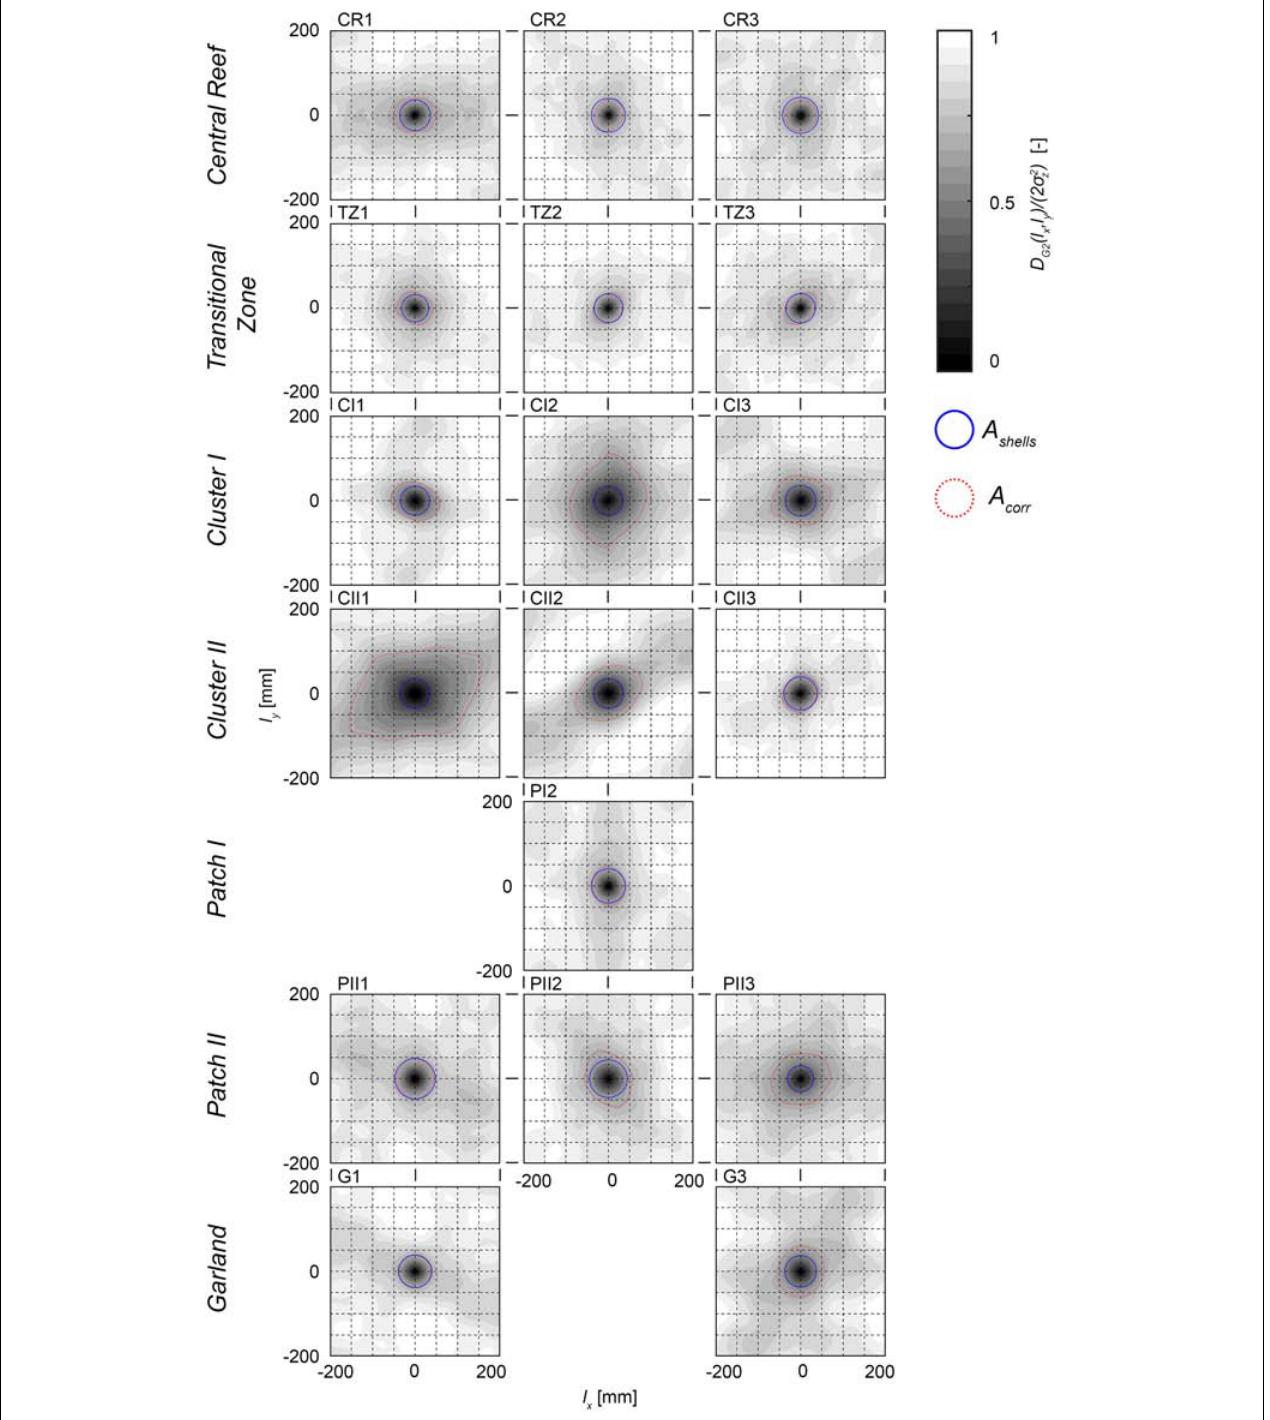
FIGURE 10 | Visualizations of the 2D second-order structure functions (2D-SSFs) for each sample surface normalized by the respective variances D G 2 (l x ,l y )/ 2 σ z 2 . The x - and y -axis show the spatial lags l x and l y [mm]. The gray scale reflects the normalized 2D-SSF values [-], where dark areas indicate high levels of correlation approaching D G 2 (l x ,l y )/ 2 σ z 2 = 0. Blue circles represent the area A shells whose radii are equal to the mean width w mean of the oyster shells; Red dashed lines illustrate the area of significant correlations A corr which is D G 2 (l x ,l y )/ 2 σ z 2 ≤ 0.7. The sub-figures are sorted by proposed structural classes. PI1, PI3, and G2 are not evaluated.